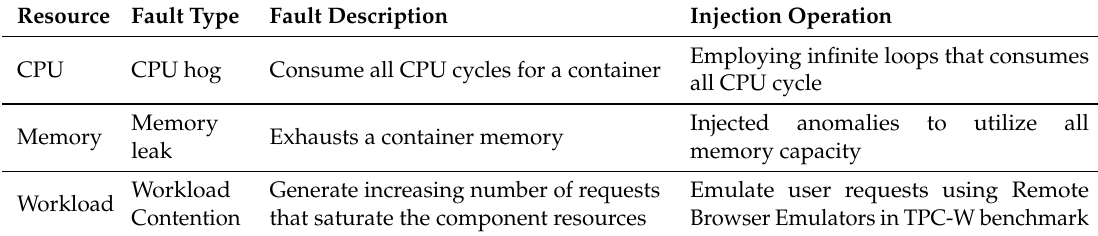
Table 5. Injected